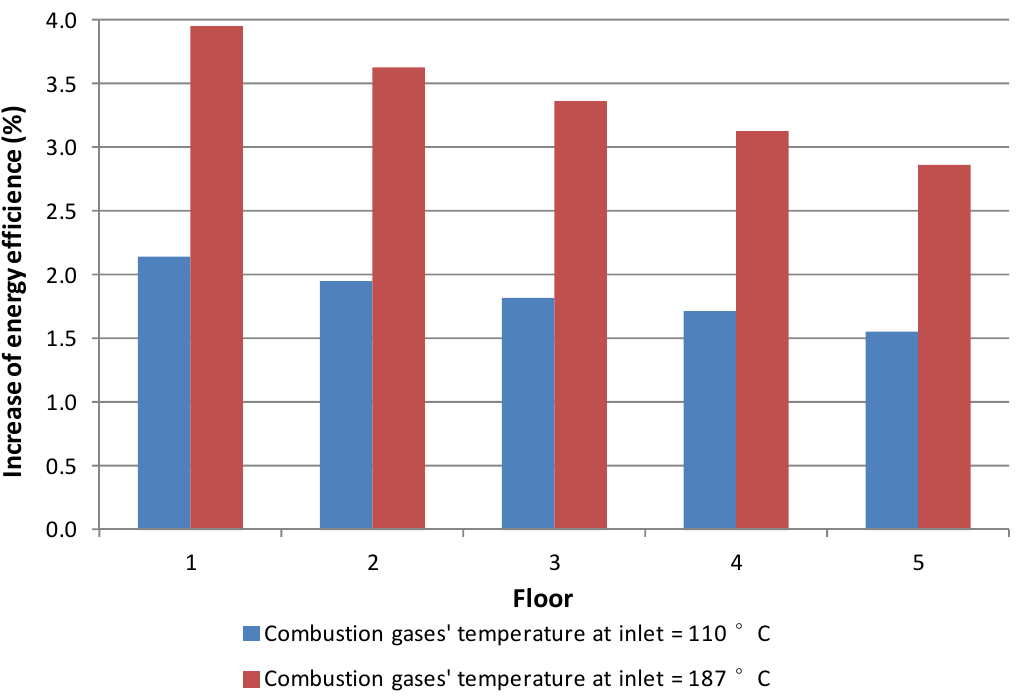
Figure 4. Increase in energy efficiency of gas appliance on each floor for different temperatures of combustion gases at